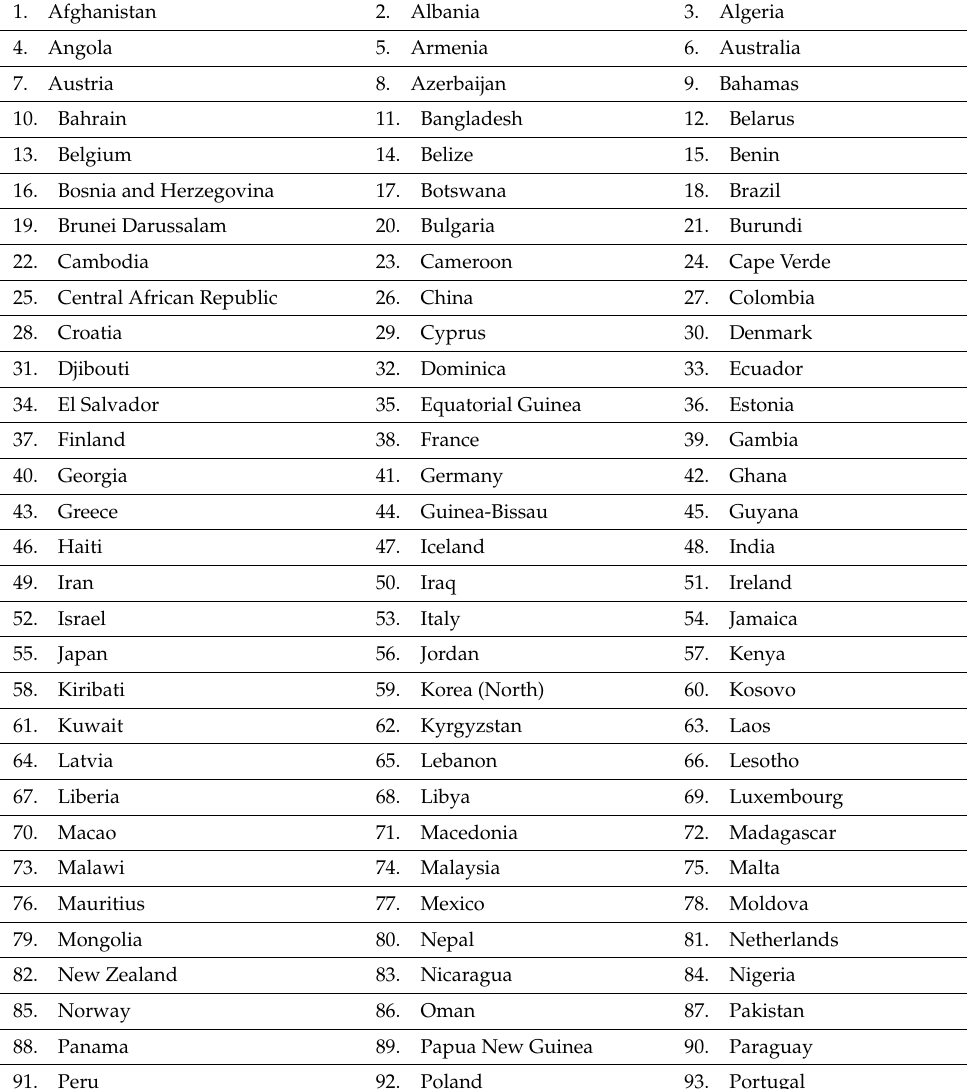
Table A1. List of